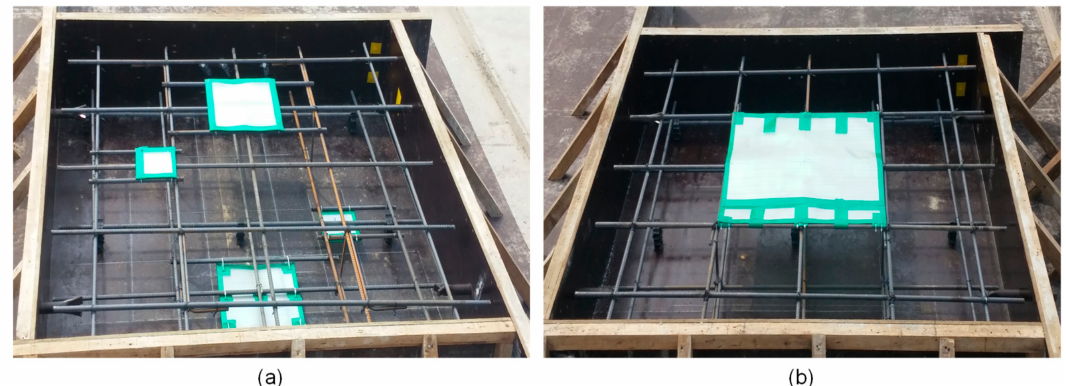
Figure 4. Actual orientation of the delamination defects installed to the reinforcing steel bars: ( a ) shallow and deep delamination defects in the concrete slab specimen 1, ( b ) a shallow delamination defect in the concrete slab specimen 2.